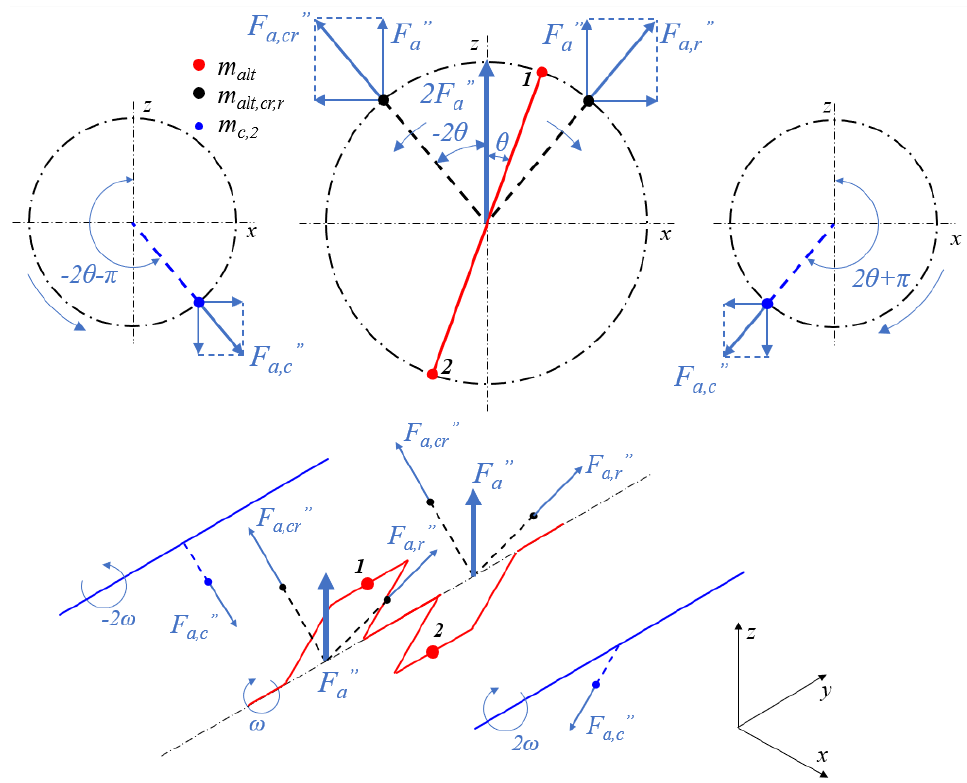
Figure 4. Polar plot and relative isometry of the crankshaft for a 2 cylinder in-line engine with a 180° angle between cranks, including the secondary reciprocating forces equilibrium and the additional secondary balancing